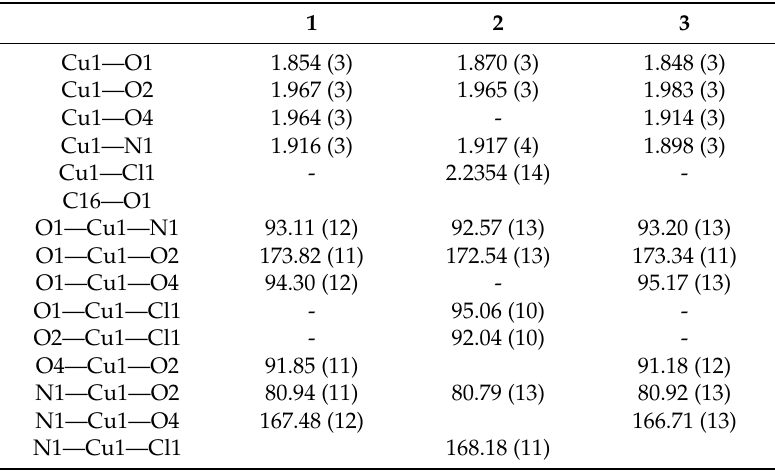
Table 2. Selected bond distances (Å) and angles ( ˝ ) in complexes 1 – 3